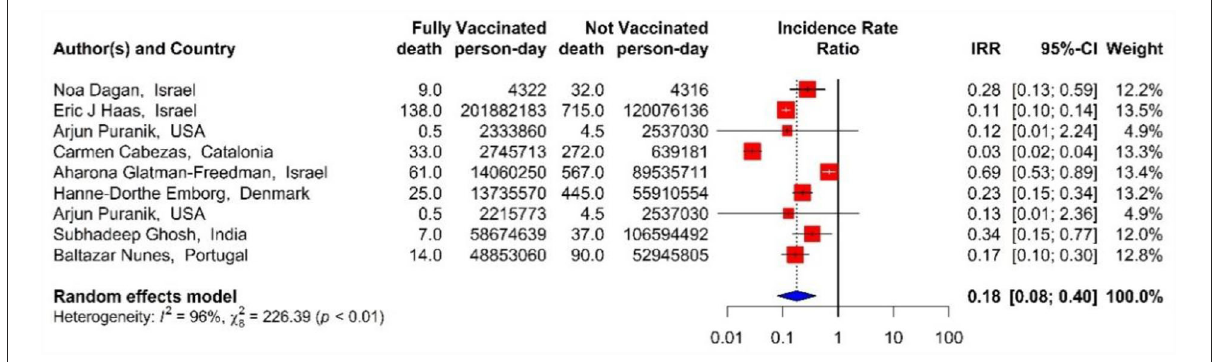
FIGURE13 Effectiveness of vaccines against COVID-19-related mortality using incidence rate ratio in full vaccinated